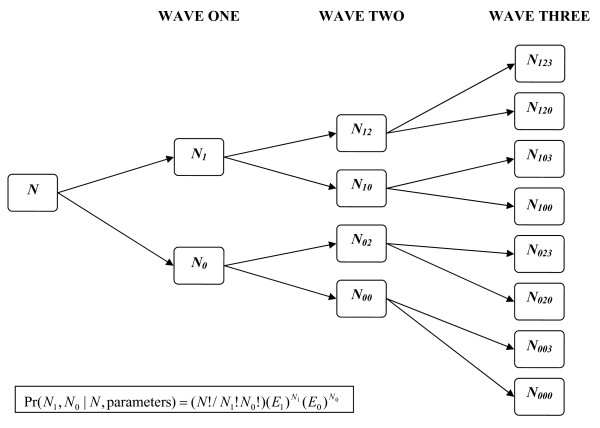
Observations over three waves. For each population there was information on N individuals, of whom N1 reported symptoms in wave 1 and N0 did not; in wave 2, N12 had a repeat attack, while N10 of those affected in wave one did not have a repeat attack; N123 individuals reported symptoms in all three waves...;;etc. The total number reporting symptoms in wave 2 was N12 + N02, while the total number for wave three was N123 + N103 + N023 + N003. The observed numbers N123, N120, N103, N100, N023, N020, N003, N000 for each population can be recovered from the proportions SAW, SA-, S-W, S- -, -AW, -A-, - -W, - - - shown in Table 1 by multiplication by the corresponding N.